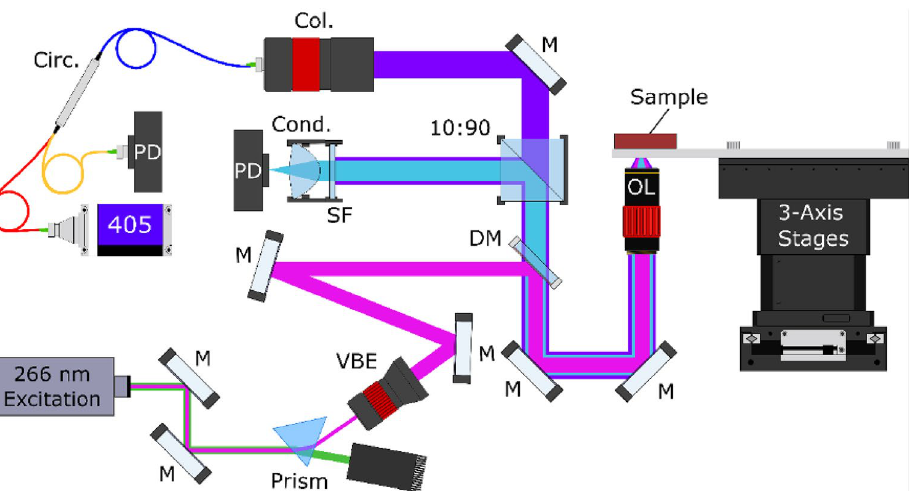
Figure 2. Simplified TA-PARS system architecture and system setup. Component labels are as follows: dichroic mirror (DM), variable beam expander (VBE), collimator (Col.), circulator (Circ.), spectral filter (SF), condenser lens (Cond.), photodiode (PD), 10:90 splitter (90:10), mirror (M) and objective lens